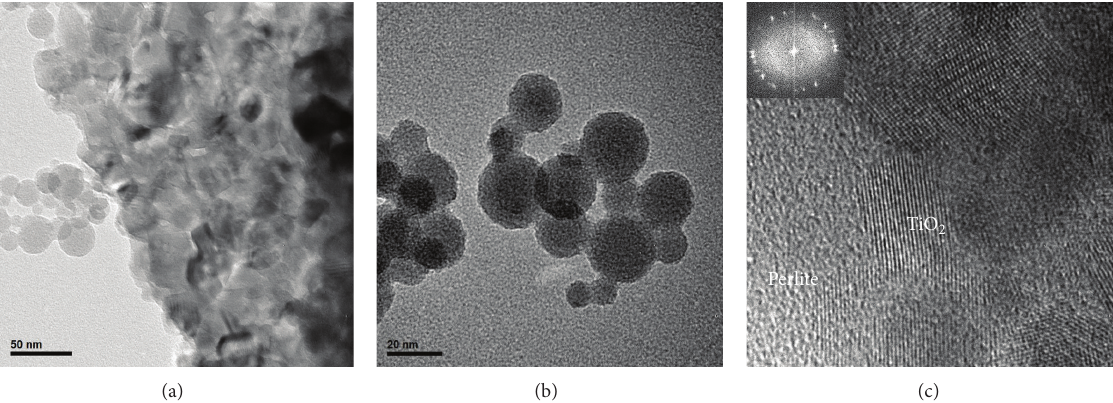
Figure 6: TEM micrographs of the composite TiO 2 /Perlite (a), TiO 2 nanoparticles (b), and HRTEM image of TiO 2 /Perlite (c).